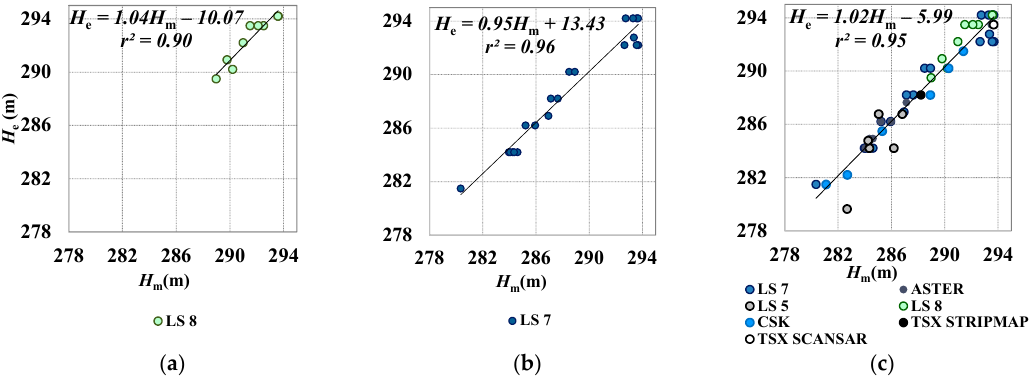
Figure 7. Water levels measured in situ ( H m ) vs. levels obtained by visual matching ( H e ) using: ( a ) LS8; ( b ) LS7; ( c ) all data.